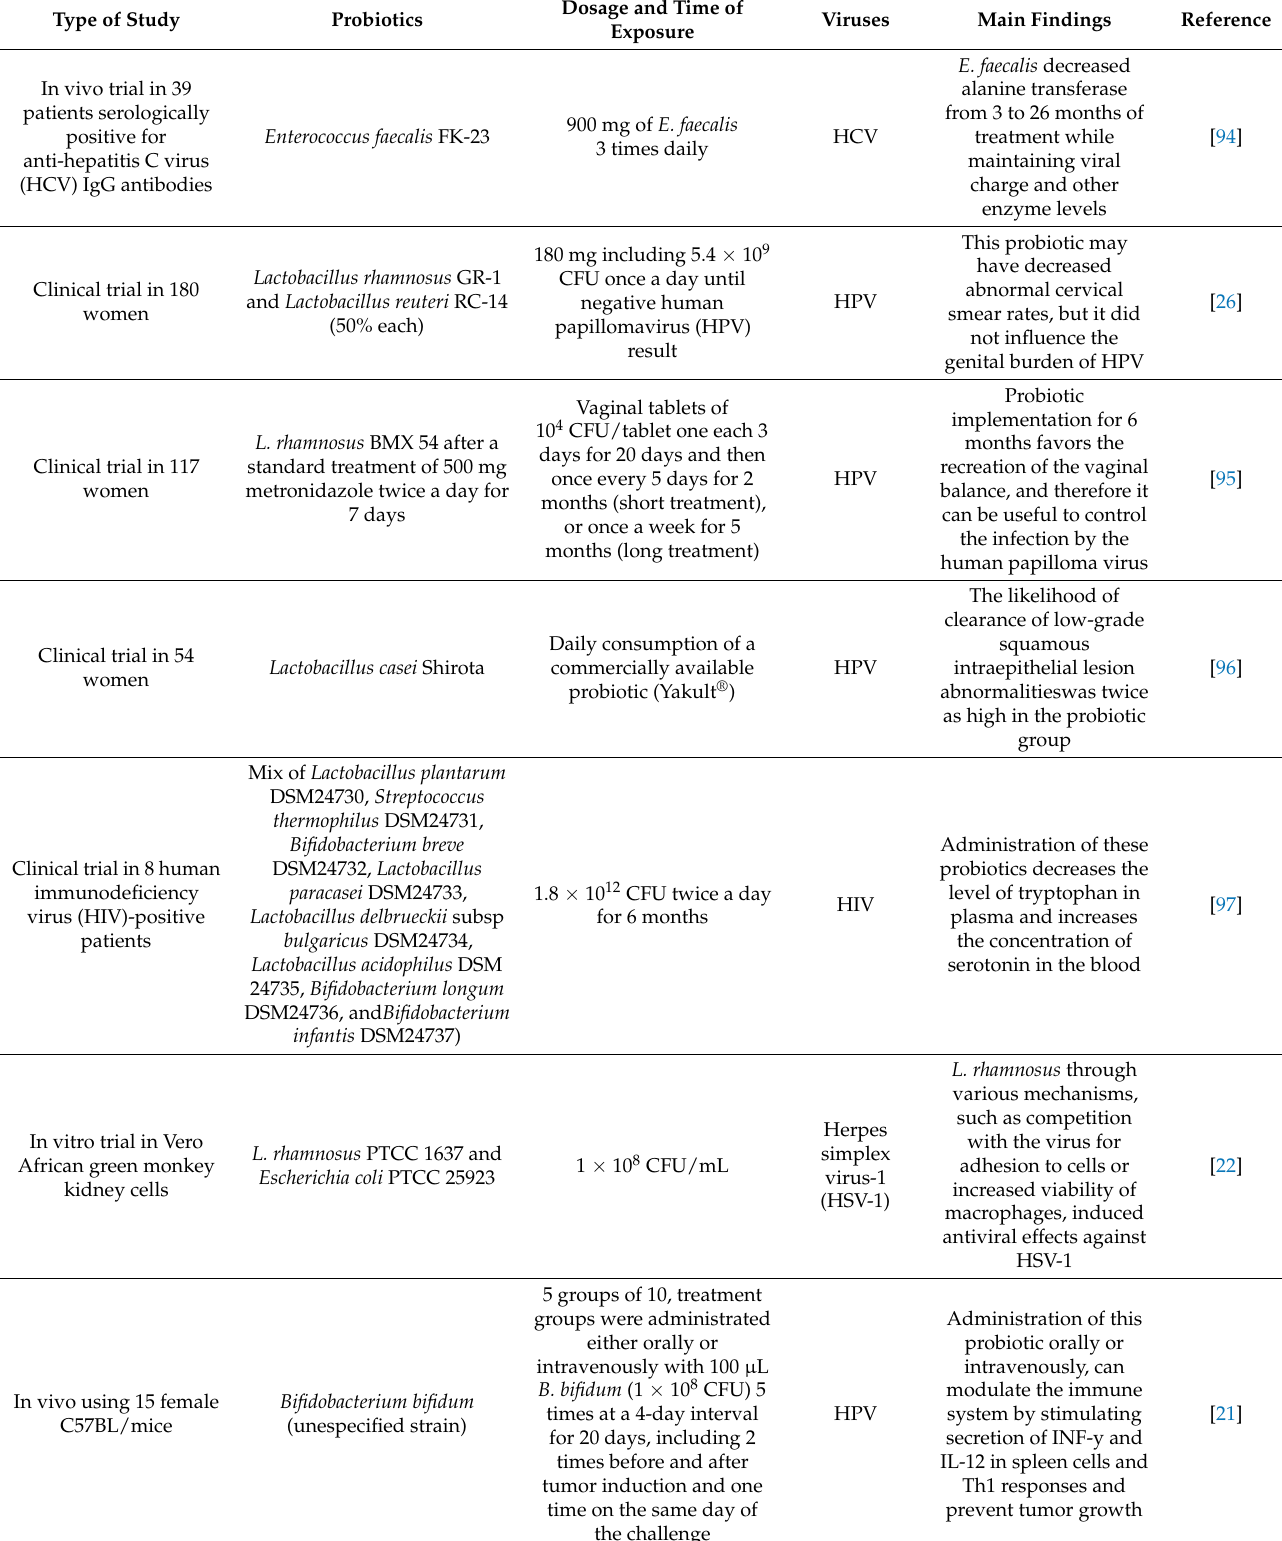
Table 3. Effects of probiotics against other